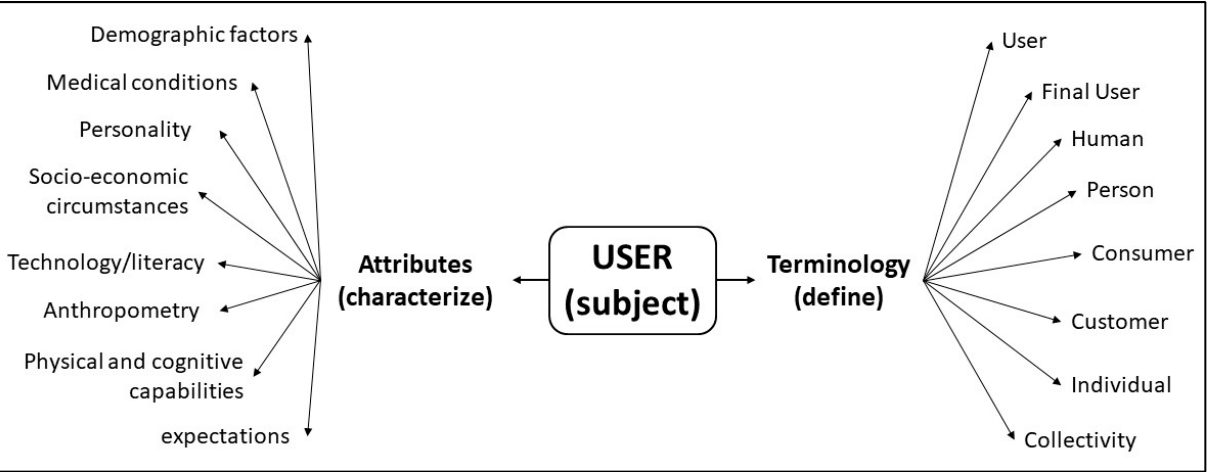
Figure 2. Terms used in the literature to define the user and to describe the attributes that characterize it.